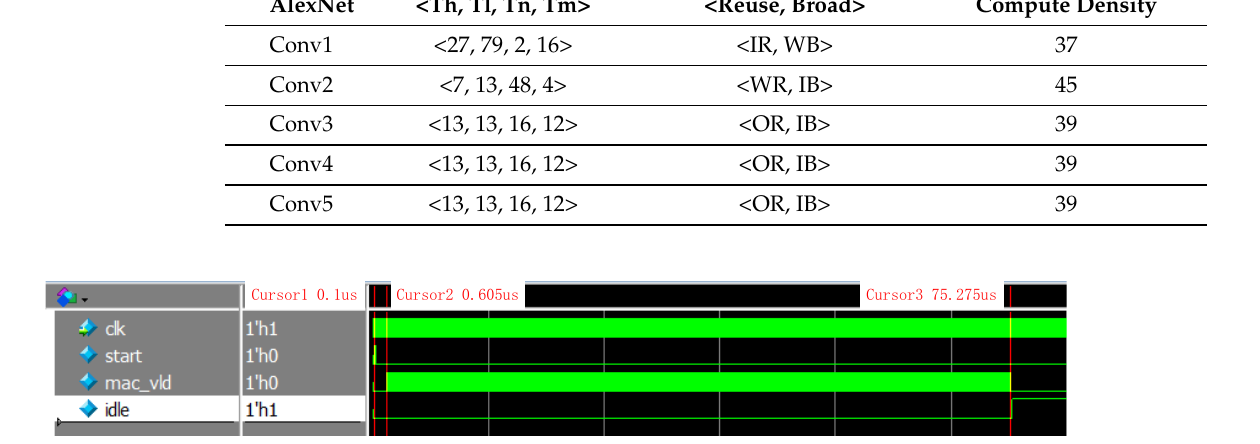
Figure 12. Simulation waveform of a